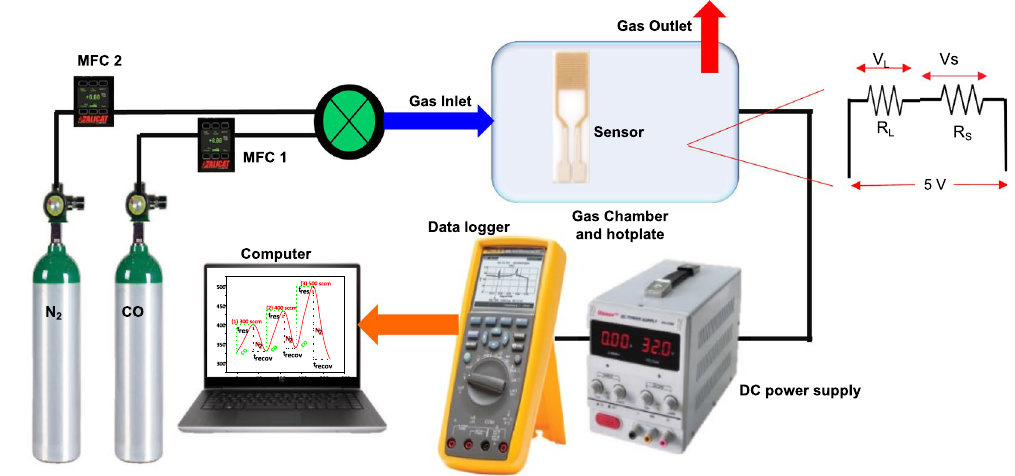
Figure 1. A schematic diagram for the experimental set-up of the gas sensing